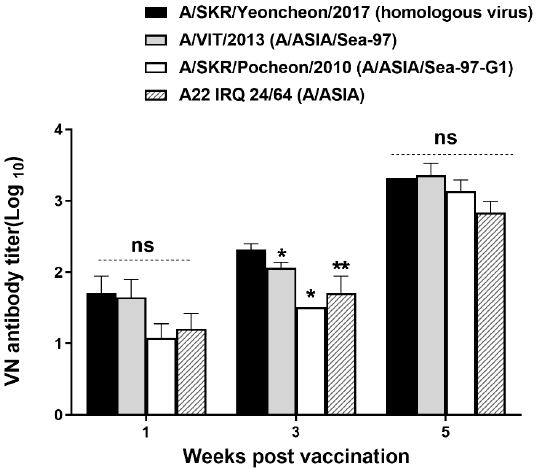
Figure 4. Comparisons of neutralizing titers against heterologous field viruses in pigs. The virus neutralization test (VNT) was carried out using sera from pigs vaccinated with the A/SKR/Yeoncheon/2017 (A-1) experimental vaccine and A/SKR/Yeoncheon/2017(homologous virus), A/VIT/2013, A/SKR/Pocheon/2010, and A22/IRQ/24/64 , and VN antibody titers were compared. Error bars indicate SDs from the mean. Statistical analysis was conducted using an unpaired t -test (* p < 0.05, ** p < 0.01, ns: not significant).